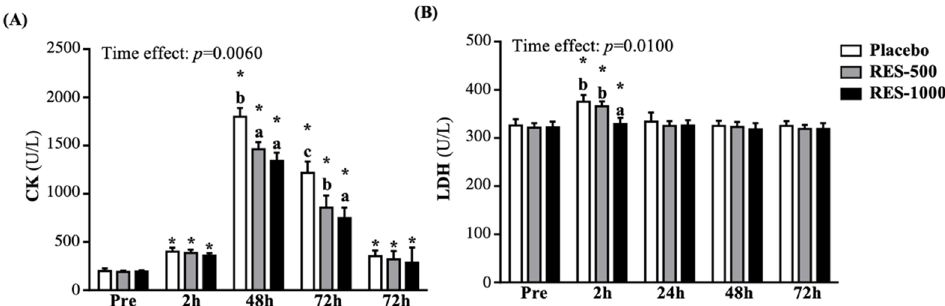
Figure 6. Effect of supplementation with RES on ( A ) CK and ( B ) LDH. Data are presented by mean ± SEM. Different superscript letters (a, b, c) indicate significant differences among the groups at p < 0.05, and administration effects were statistically analyzed with a paired Student’s t -test, * p < 0.05. CK, creatine kinase; LDH, lactate